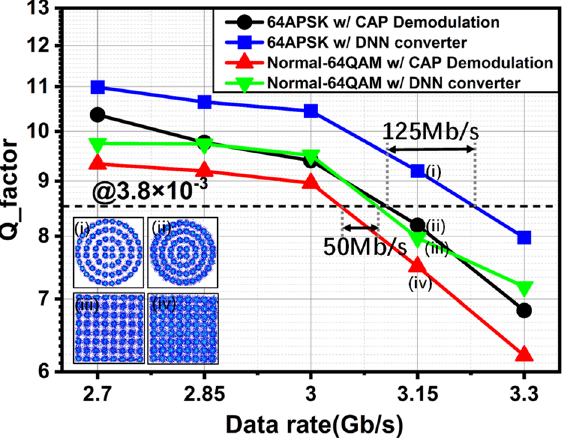
Figure 8. BER versus different Bit rate for 64APSK and 64QAM UVLC systems. ( i , ii ) show the constellation points of DNN converter and CAP demodulation in 64APSK UVLC systems when data rate is 3.15 Gb/s, respectively. ( iii , iv ) show the constellation points of DNN converter and CAP demodulation in 64QAM UVLC systems when data rate is 3.15 Gb/s, respectively.